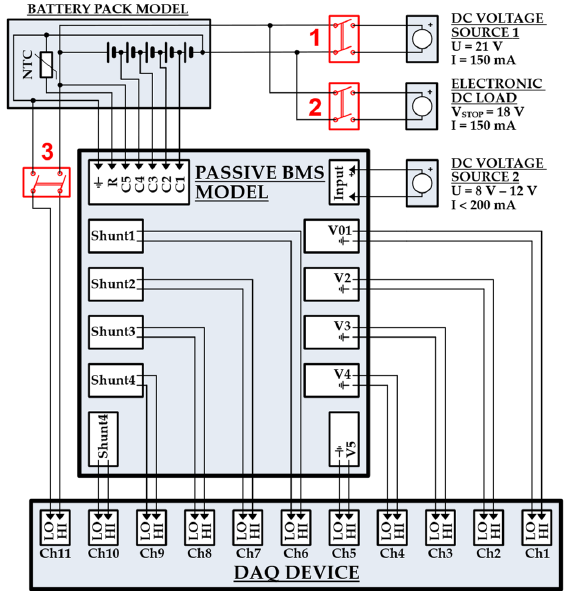
Figure 11. Passive BMS connection diagram.